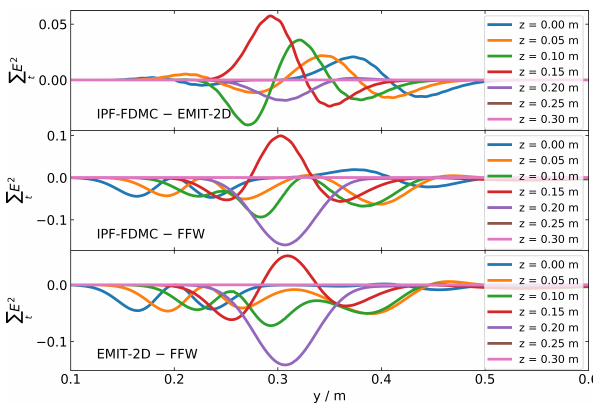
Figure 7. Di ff erence of the detector antenna signals obtained from the full-wave simulations for scenario #5.